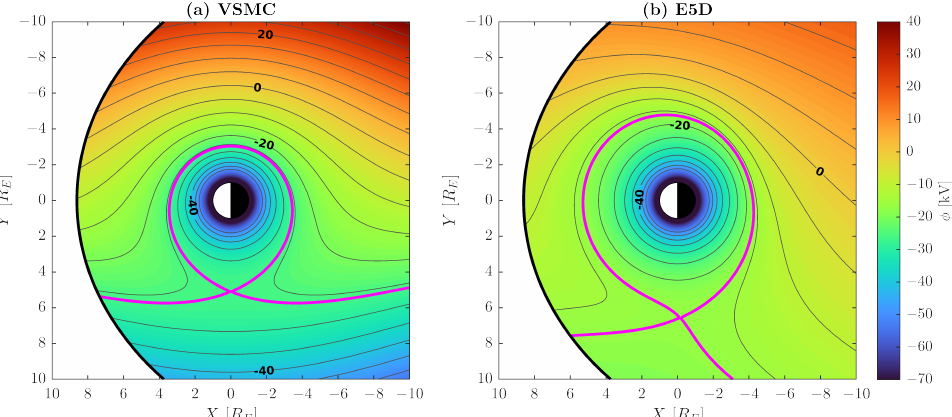
Figure 3. Different representations of the inner magnetospheric equatorial electric potential on 2 June 2013 at 01:24 ( Kp = 4), as determined by the VSMC ( a ) and E5D ( b ) models. The colors indicate the magnitude in kV of the electric potential. Equipotential lines are drawn only for φ ≥ − 50 kV, with a step of 5 kV. The values of the potential are also indicated directly on selected contours. The magenta lines are the ZEABs. The magnetopause position is from the Shue et al. [80]